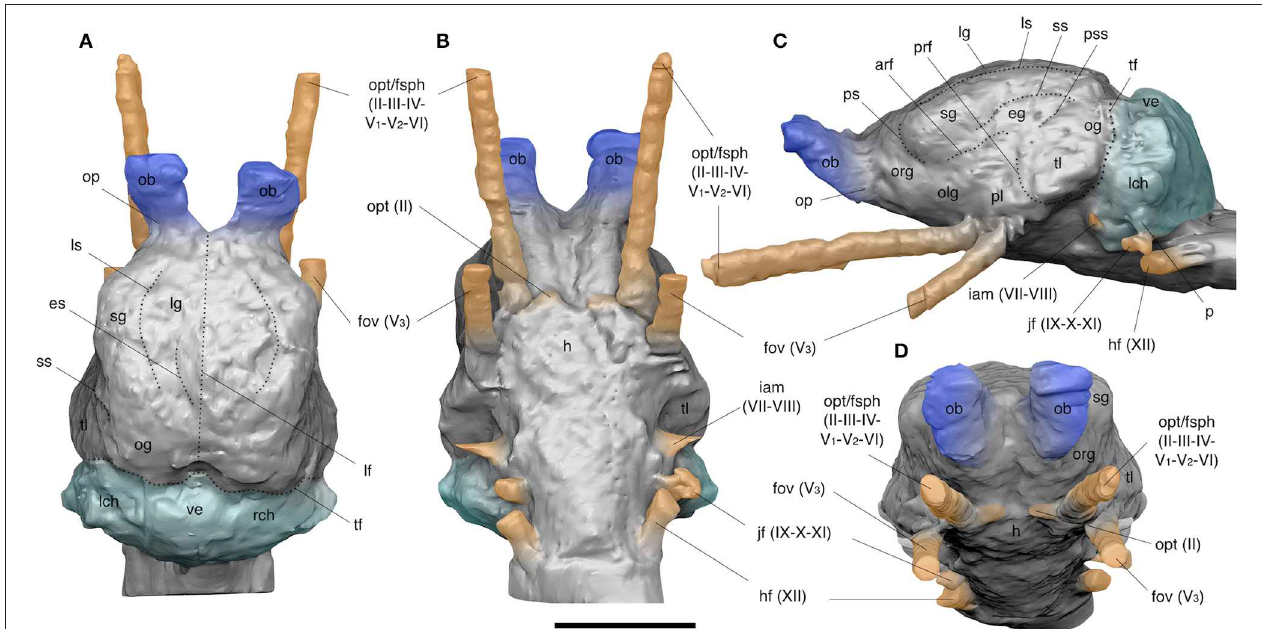
FIGURE 6 | Digital reconstructions of the brain cavity of Catonyx tarijensis MNHN-Bol V 13364 from the Pleistocene of Oruro (Bolivian Altiplano) in dorsal (A) , ventral (B) , lateral (C) , and anterior (D) views. arf, anterior rhinal fissure; eg, ectosylvian gyrus; es, entolateral sulcus; fov, foramen ovale groove; h, hypophysis; hf, hypoglossal foramen groove; iam, internal acoustic meatus; jf, jugular foramen groove; lch, left cerebellar hemisphere; lf, longitudinal fissure; lg, lateral gyrus; ls, lateral sulcus; ob, olfactory bulb; og, occipital gyrus; olg, olfactory gyrus; op, olfactory peduncle; opt, optic nerve; opt/fsph, common groove for the optic foramen and sphenorbital fissure; org, orbital gyrus; p, paraflocculus; pl, pyriform lobe; prf, posterior rhinal fissure; ps, presylvian sulcus; pss, pseudosylvian sulcus; rch, right cerebellar hemisphere; sg, suprasylvian gyrus; ss, suprasylvian sulcus; tf, transverse fissure; tl, temporal lobe; ve, vermis. Colors indicate: gray, cerebrum; blue, olfactory bulbs; turquoise, cerebellum; orange, neurovascular connections. Roman numeral designations indicate cranial nerves. Scale bar equals